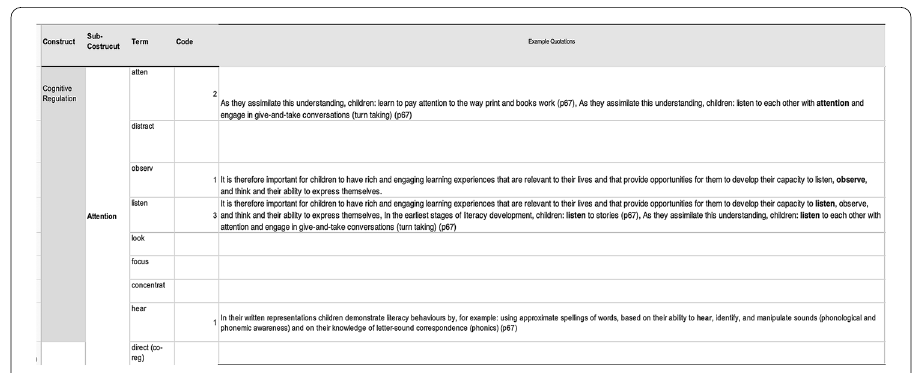
Fig. 1 Example screenshot of Cognitive Regulation for the ‘Thinking About Literacy and Mathematics’ frame of the kindergarten curriculum